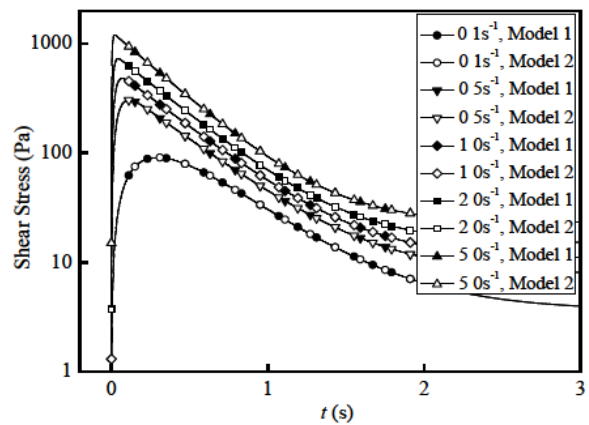
Table 1: Basic physical properties of experimental oil samples Freezing